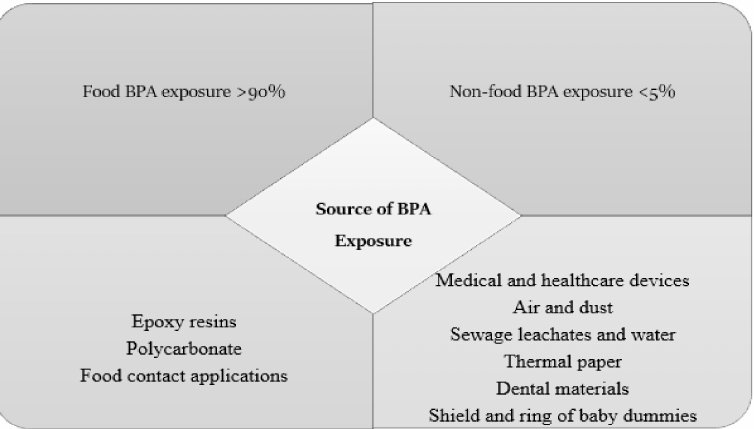
Figure 2. Food and non-food exposure to BPA